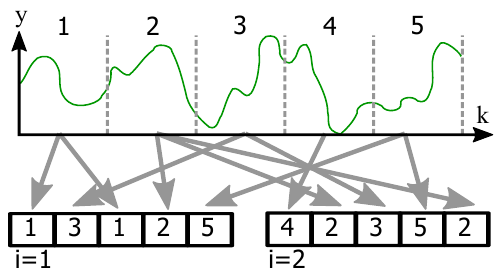
Figure 5: An example of simple block bootstrapping with K = 5 blocks, creating M = 2 pseudo data-sets.